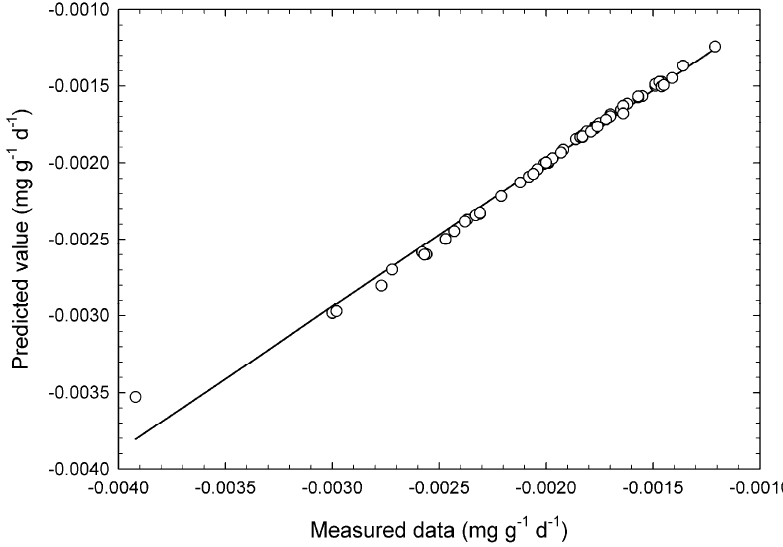
Figure 5. Validation for predicting the chlorophyll degradation velocity of broccoli heads at 60 regions of interest by artificial neural networks. The open circles and full line are the actual values and single regression line. Bias was − 4.82 × 10 − 7 mg·g − 1 ·d − 1 , standard error of prediction 5.37 × 10 − 5 mg·g − 1 ·d − 1 , and correlative coefficient of validation was 0.995. This level of correlation was significant at the 99.9% level calculated using the F-test.